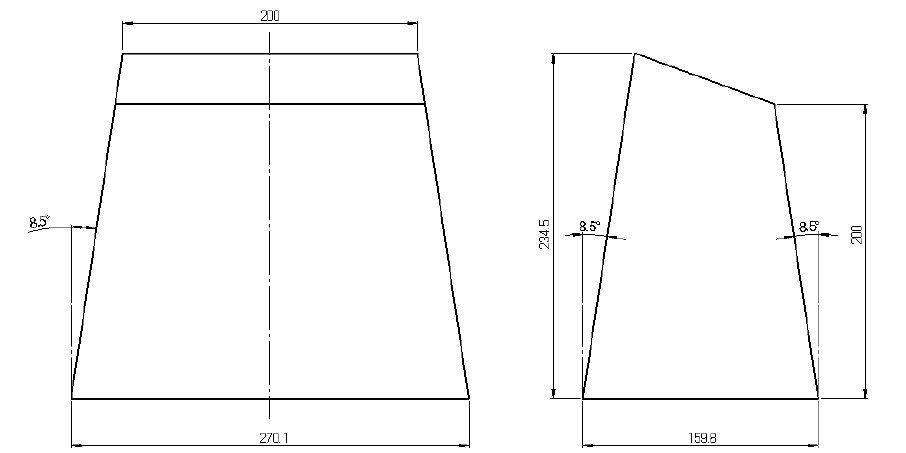
Figure 1. Geometry of the impact attenuator used in the case study. The truncated pyramid with rectangular base is made with plates (2.5 mm thick) welded along the edges. It is inscribed within an envelope measuring 234.5 mm × 159.8 mm × 270.1